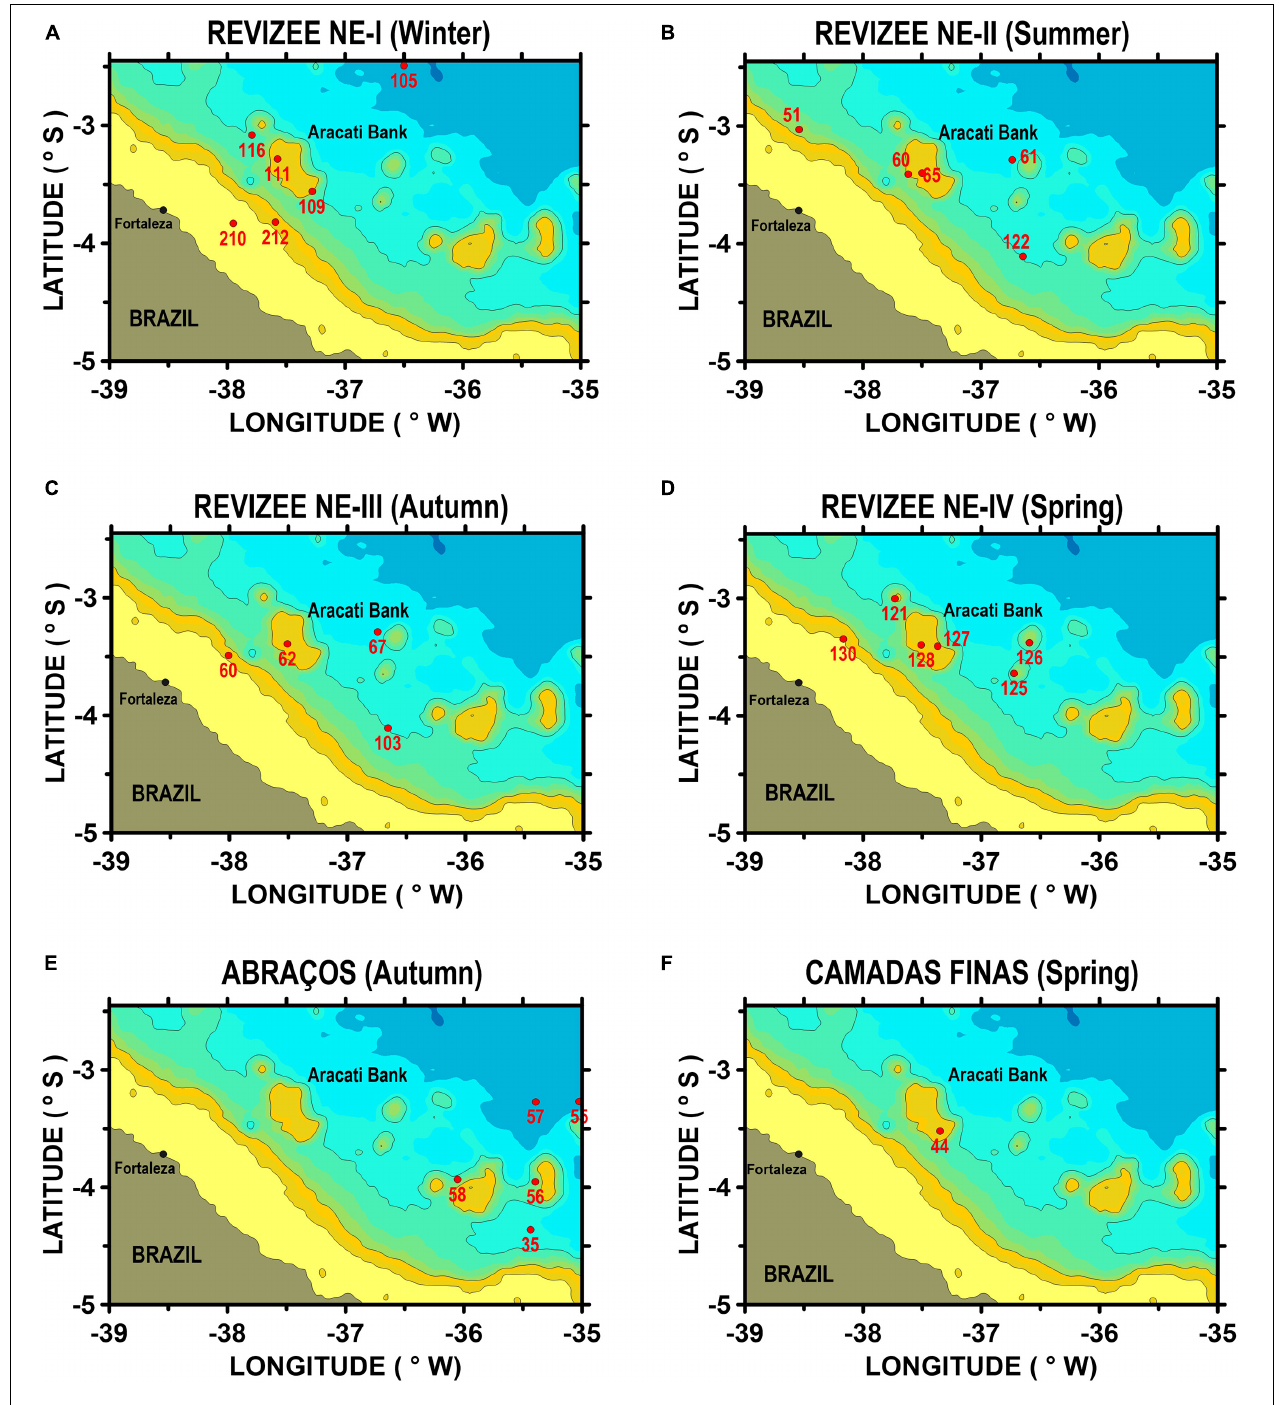
FIGURE 2 | Study area with sampling station locations in the North Brazilian Chain (NBCh) during cruises (A) REVIZEE NE-I, winter; (B) REVIZEE NE-II, summer; (C) REVIZEE NE-III, autumn; (D) REVIZEE NE-IV, spring; (E) ABRAÇOS II, autumn; and (F) CAMADAS FINAS III, spring.